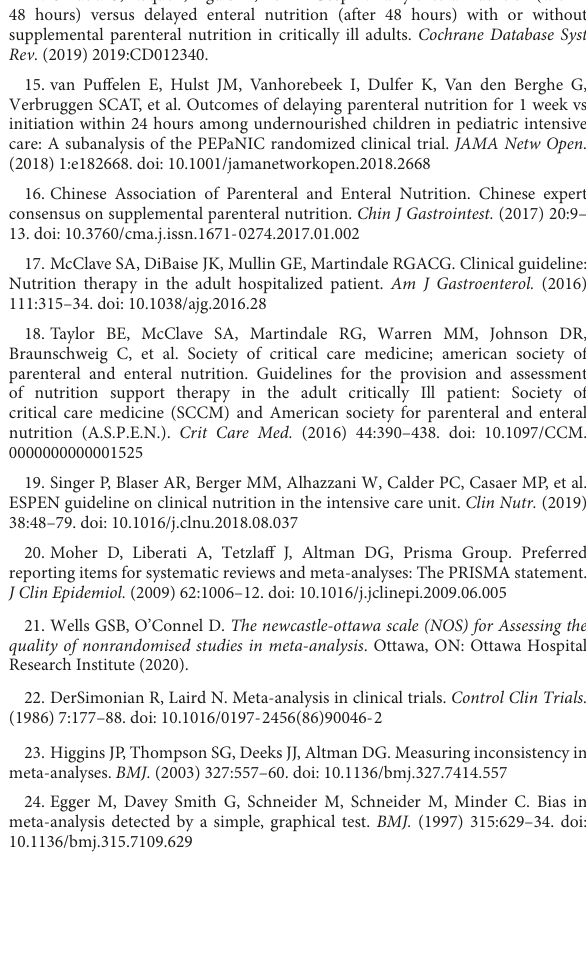
SUPPLEMENTARYFIGURE2 Effect of SPN and EN nutritional support treatment on mortality. SUPPLEMENTARYFIGURE3 Subgroup analysis of mortality in different subsets. SUPPLEMENTARYFIGURE4 Trial sequential